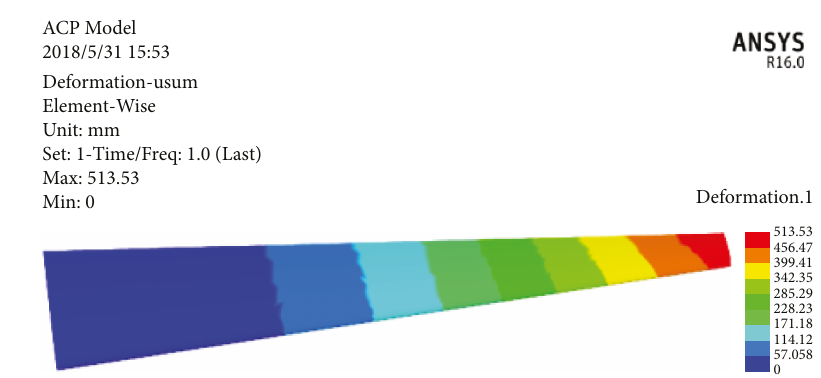
Figure 56: Deformation cloud diagram with the layer ratio being